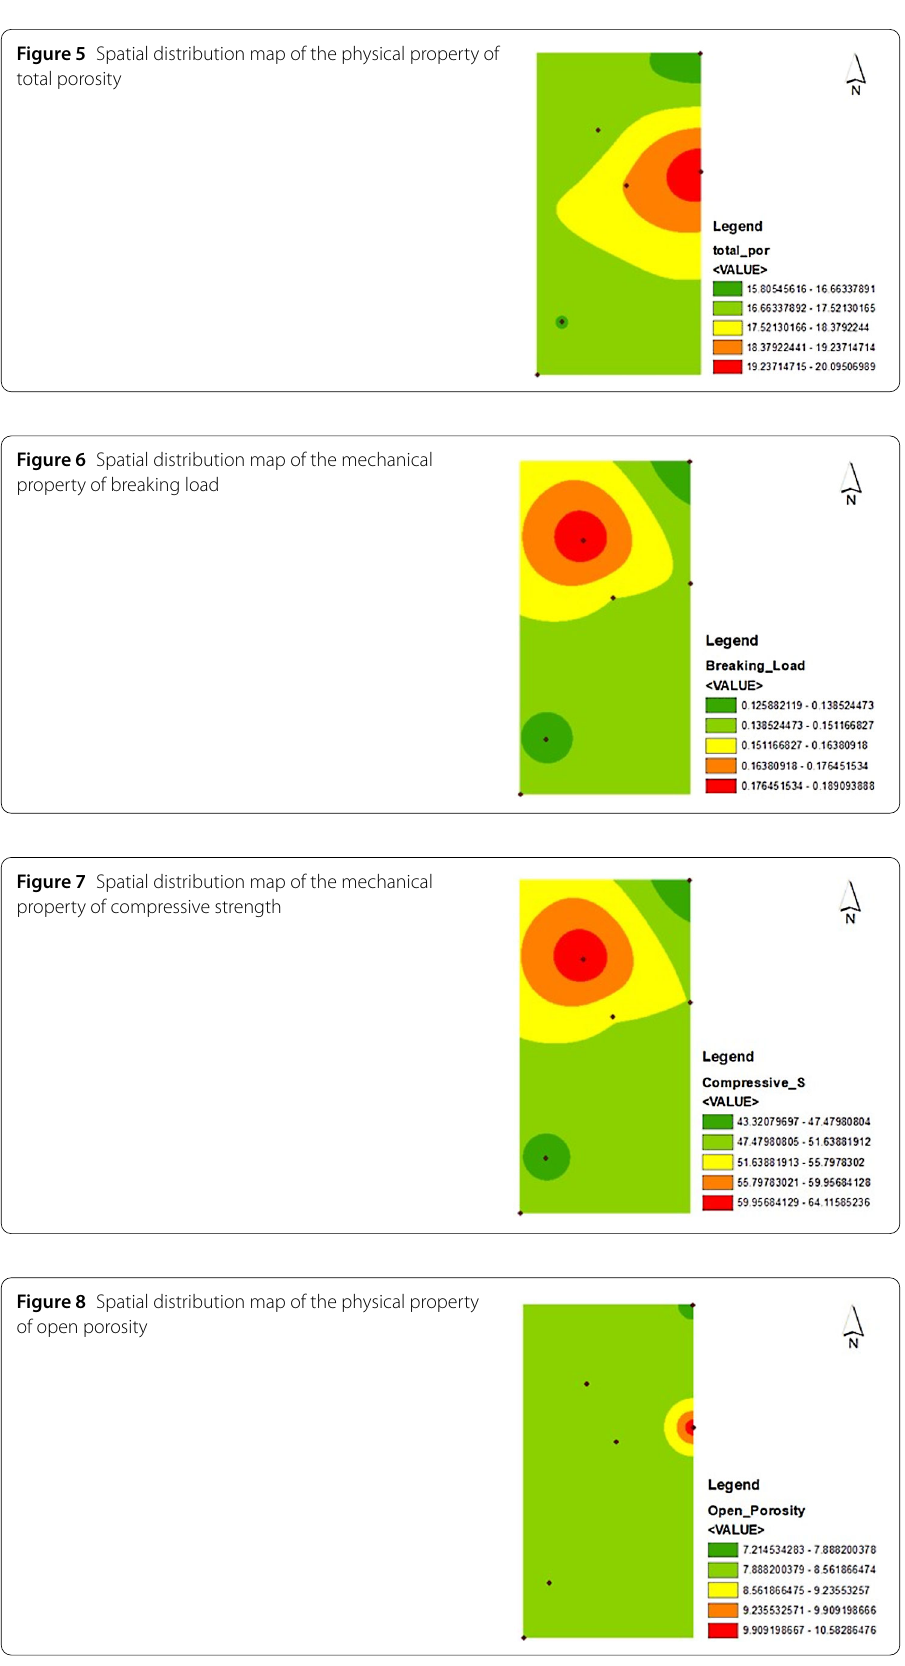
Figure 5 Spatial distribution map of the physical property of total porosity